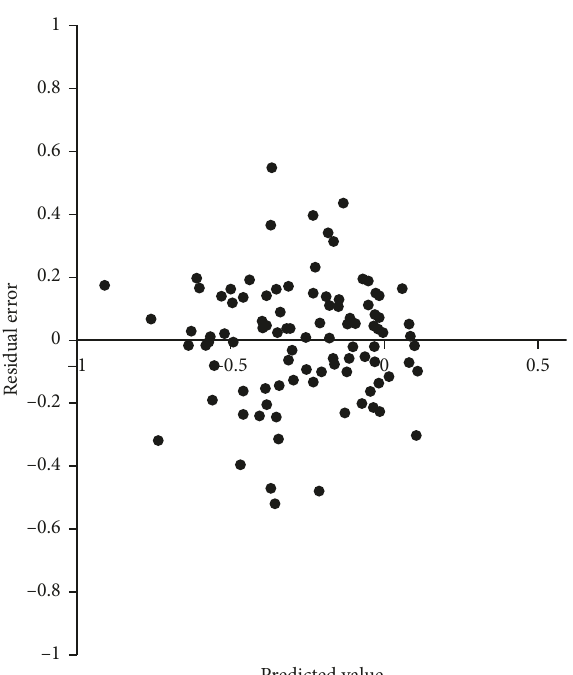
Figure 2: Residual plots of postoperative refractive J45 in multi- variate regression